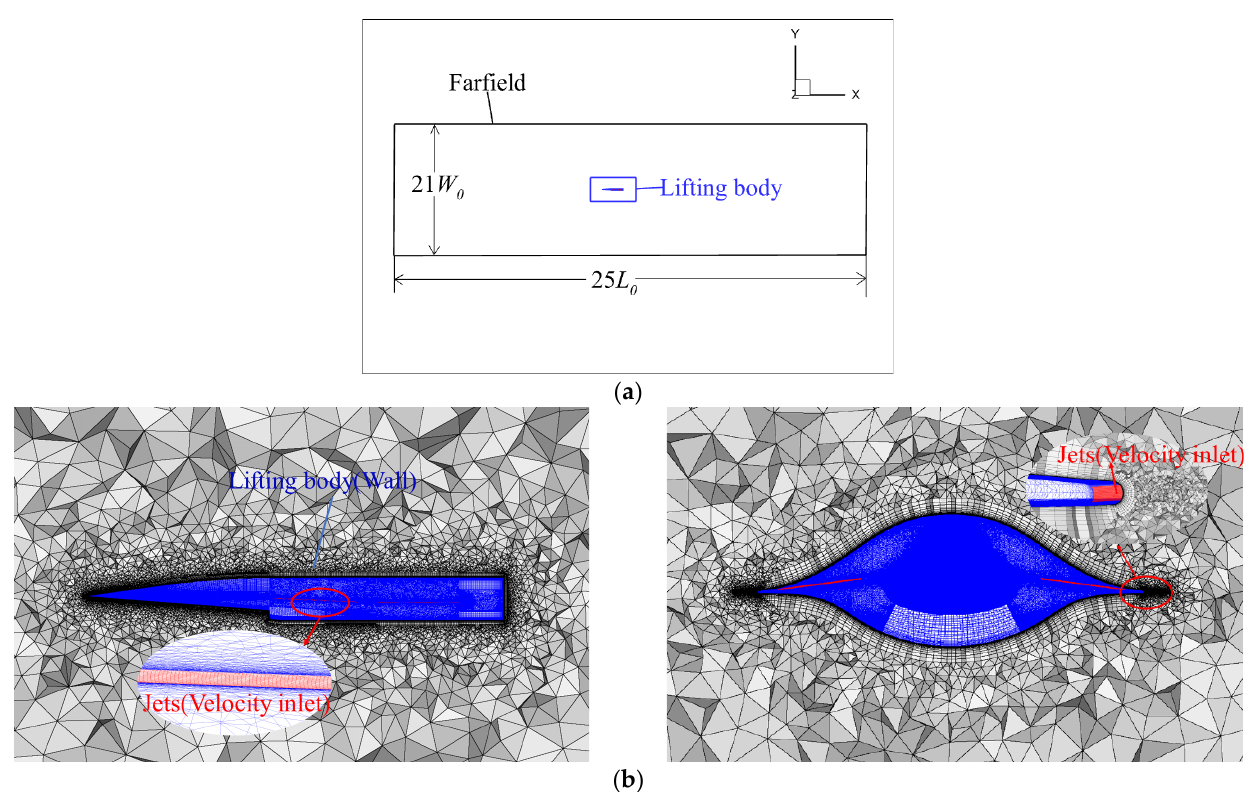
Figure 2. Computational grid. ( a ) Grid topology; ( b ) Surface and slice grid.